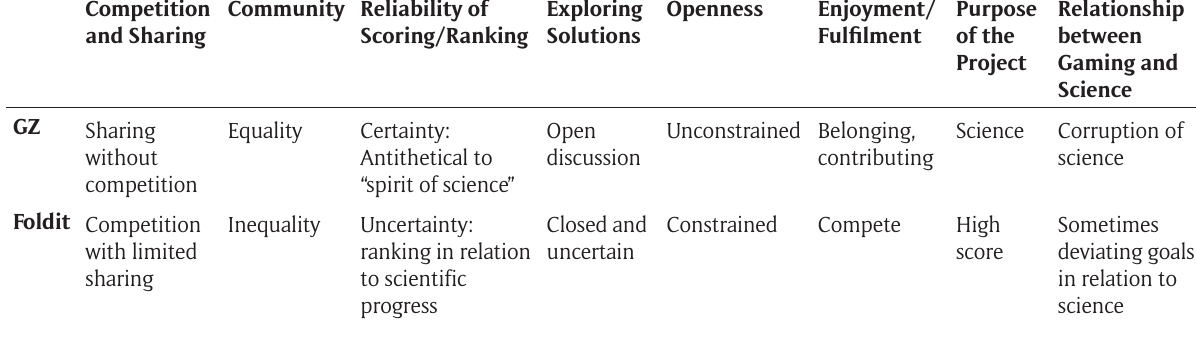
Table 4: Overview of the